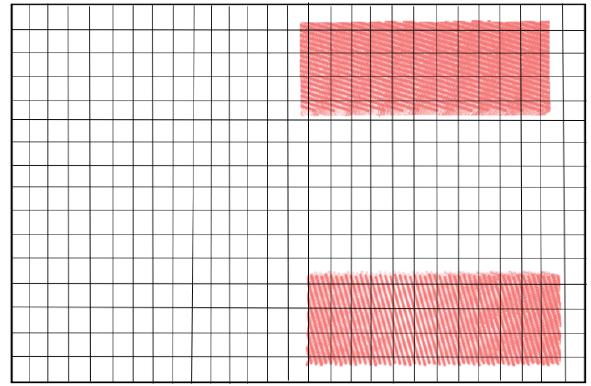
Figure 4. Division of the elevated area to find corners.